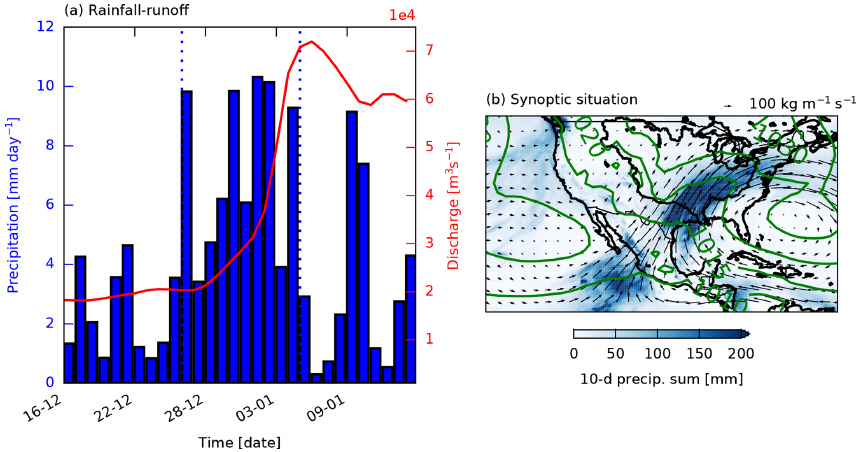
Figure 16. In (a) precipitation (in blue) and discharge (in red) for the Mississippi are shown 20 days before and 10 days after the selected event. The vertical dotted lines indicate the 10-day period, which is spatially summed in (b) . The contour lines in (b) indicate the 10-day average mean sea level pressure in hPa and the arrows the 10-day averaged vertical integrated moisture fluxes in kgm − 1 s − 1